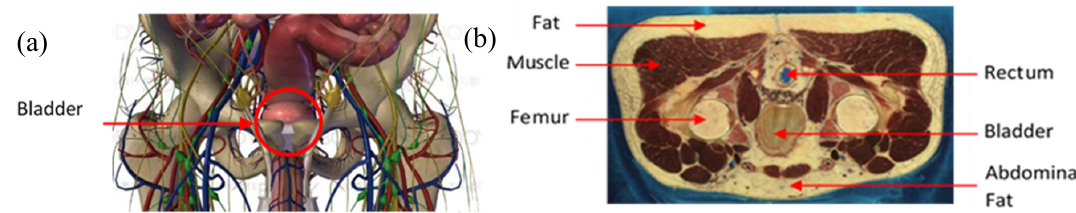
Figure 2. ( a ) Anatomy of the pelvic cavity showing the bladder’s location; ( b ) axial computer tomography (CT) scan of the pelvic cavity presenting the nature and location of the tissues. Table 1. Electrical conductivity values of the di ff erent tissues to be